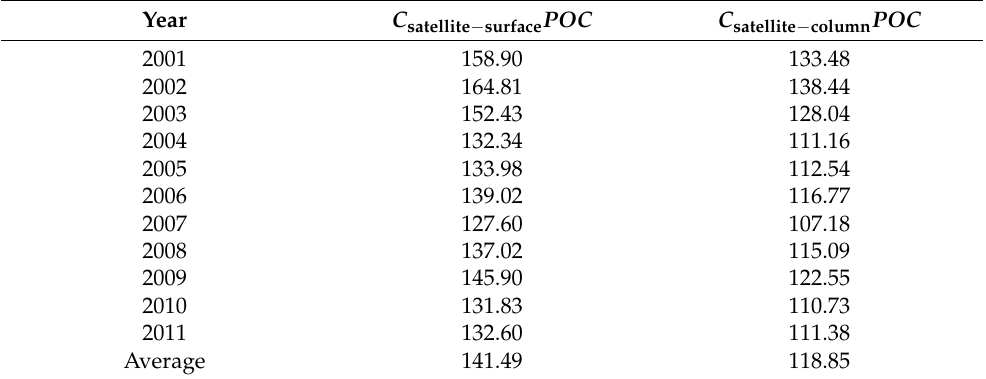
Table 3. Annual satellite data of POC in ECS (Unit: mg m − 3 ). Year